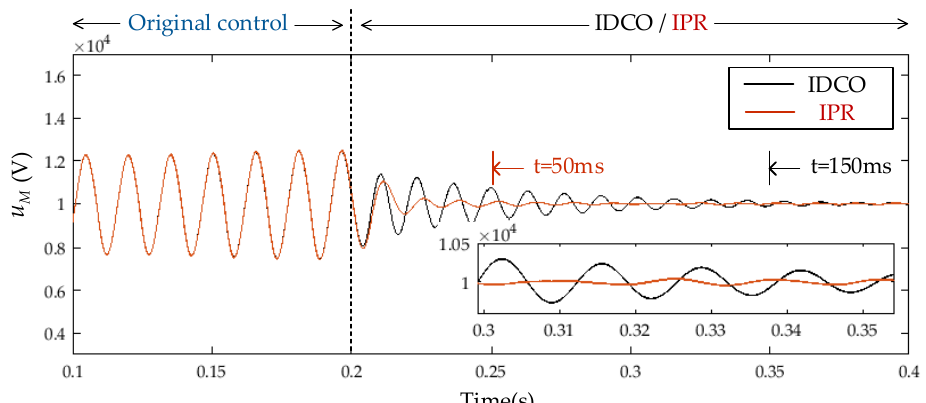
Figure 17. Damping results of the MV bus voltage u M . From Figure 17, we can see that for the IDCO and the IPR method, the oscillation of the MV bus voltage u M is suppressed within 150 ms and 50 ms, respectively. This confirms that the IPR method rapidly suppresses the MV bus voltage oscillation. Moreover, the ripple of u M using the proposed IPR method is smaller than that of the IDCO approach, because the negative resistance characteristic of the ISOP DCT is weakened.